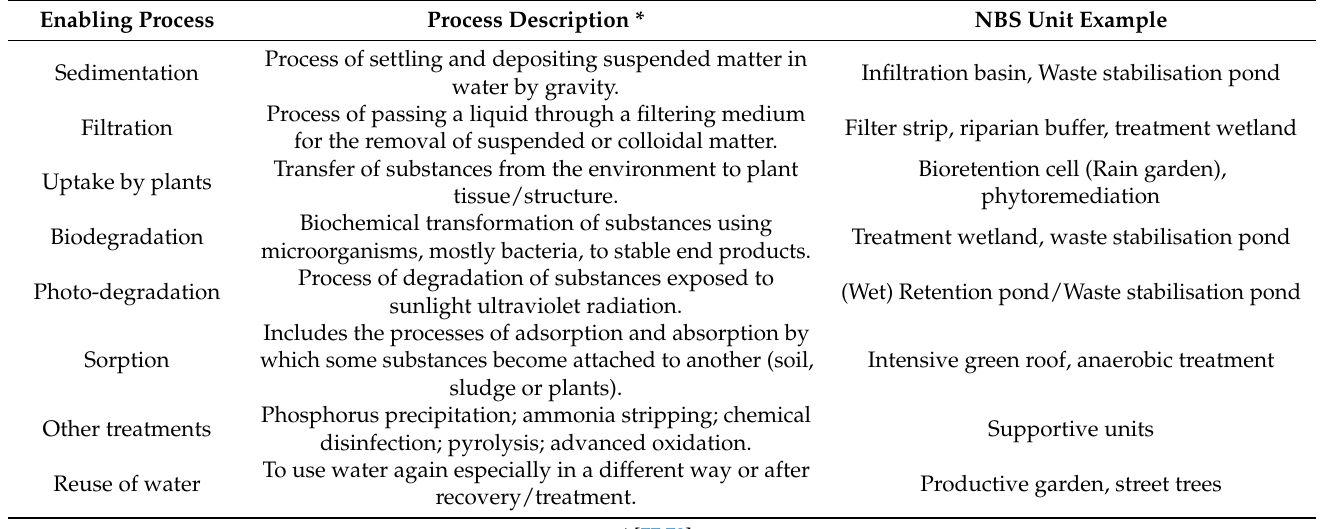
Table 3. Enabling processes for achieving UCC2: water—treatment, recovery, and